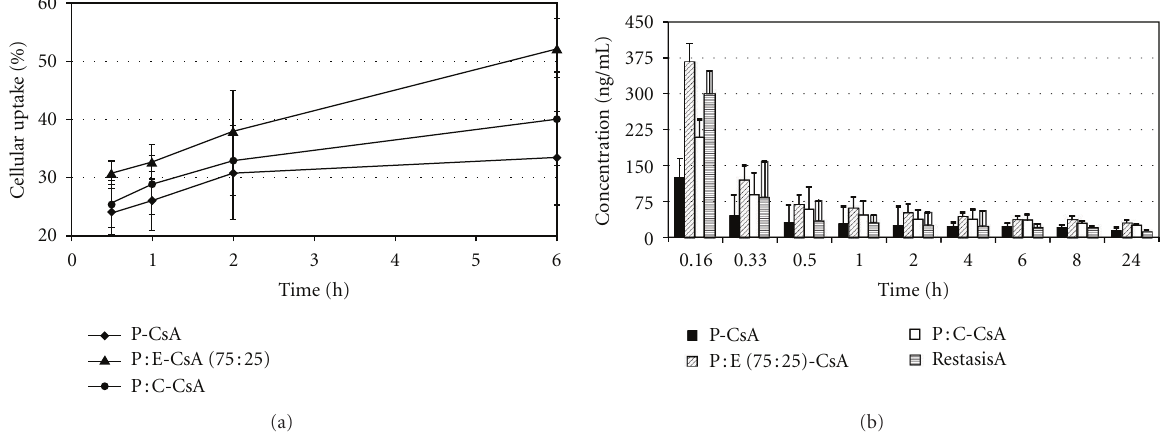
Figure 3: (a) Cellular uptake e ffi ciency (%) of Nile red labelled NPs, (b) CsA tear film concentration after administration of a single topical dose to rabbits ( n = 6) [8]. (P-CsA = PLGA-CsA, P-E-CsA = PLGA:Eudragit-CsA, P-C-CsA = PLGA-Carbopol-CsA.)